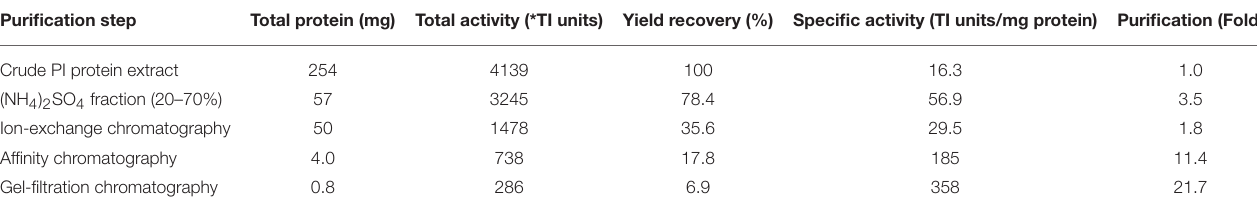
TABLE 1 | Purification of trypsin-specific PIs “CpPI 63” from mature seeds of C. platycarpus. Purification